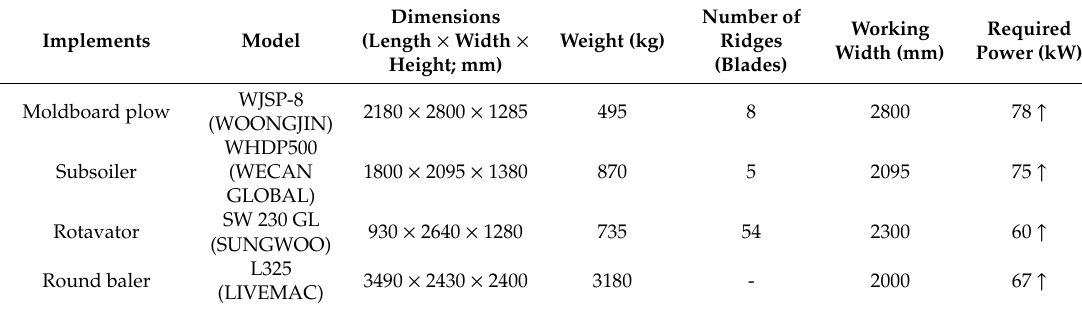
Table 5. Detailed specifications of major attached implements used in this